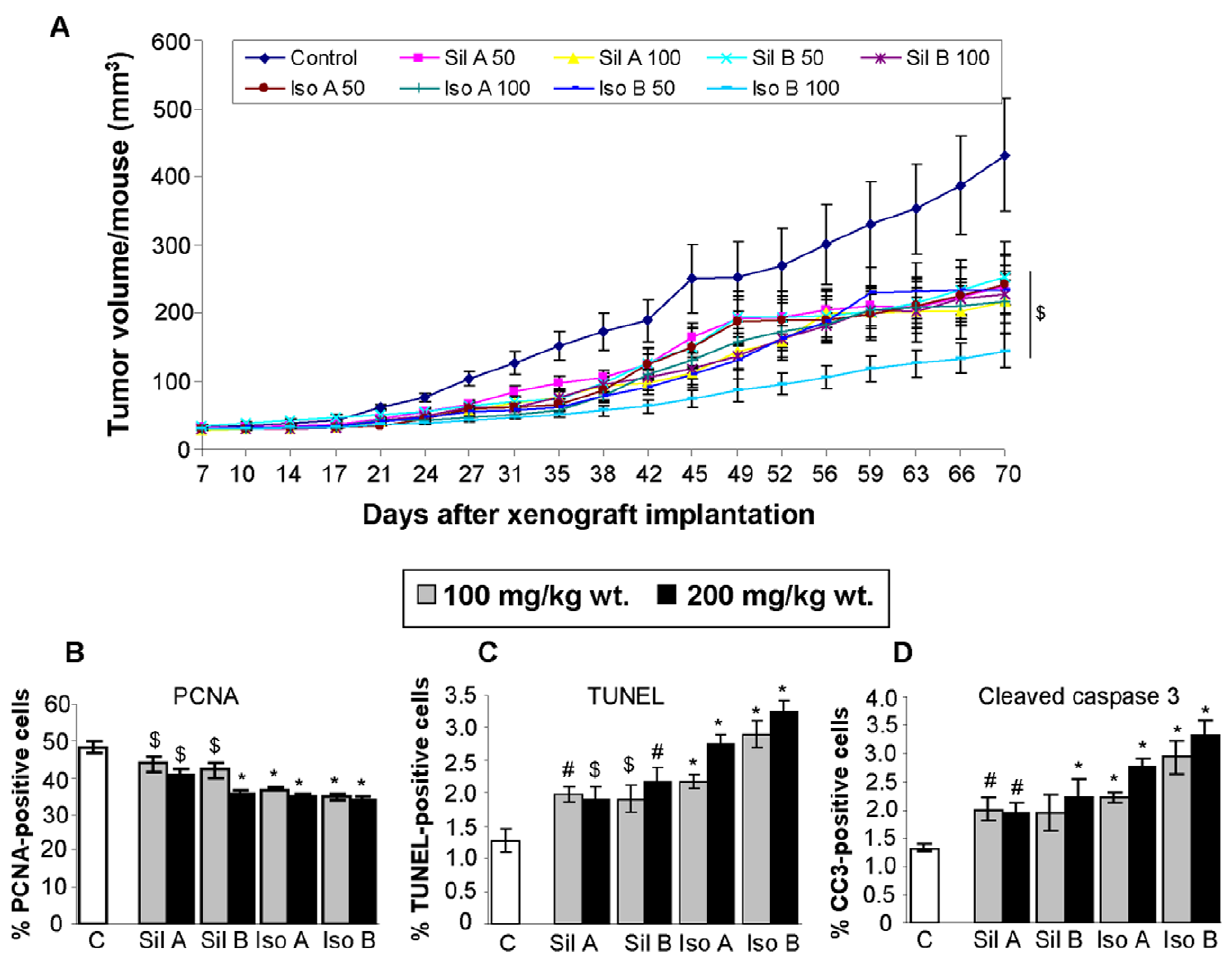
Figure 1. Flavonolignans inhibit PCA DU145 xenograft growth through targeting proliferation and apoptosis. DU145 xenografts were initiated and mice were administered either vehicle (CMC) or 50 and 100 mg/kg body weight doses of each diastereoisomer. ( A ) Tumor volume was measured and plotted as a function of time (days). Each value in the curves is mean 6 SEM of 10–12 mice. ( B–D ) Xenograft tissues were analyzed for PCNA, TUNEL and cleaved caspase-3 (CC3) by IHC. The data shown in the bar diagrams is the mean 6 SEM of 4–5 samples. Abbreviations: Sil A: Silybin A; Sil B: Silybin B; Iso A: Isosilybin A, Iso B: Isosilybin B; *, p # 0.001; # , p # 0.01; $ , p # 0.05.